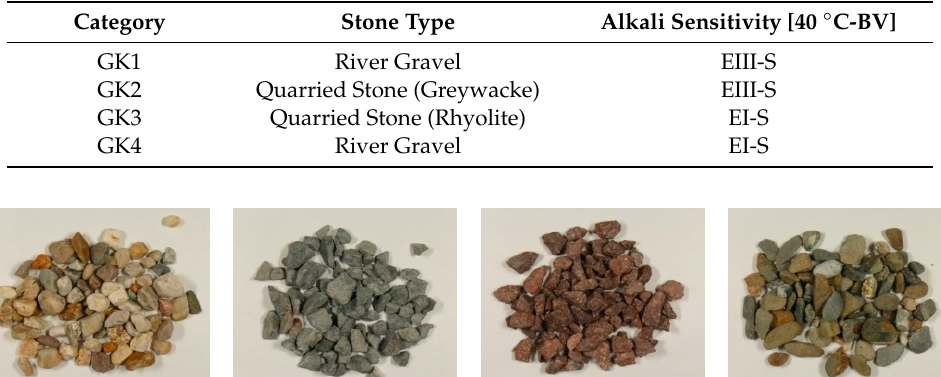
Table 1. Categories of stone selected for cracking analysis.